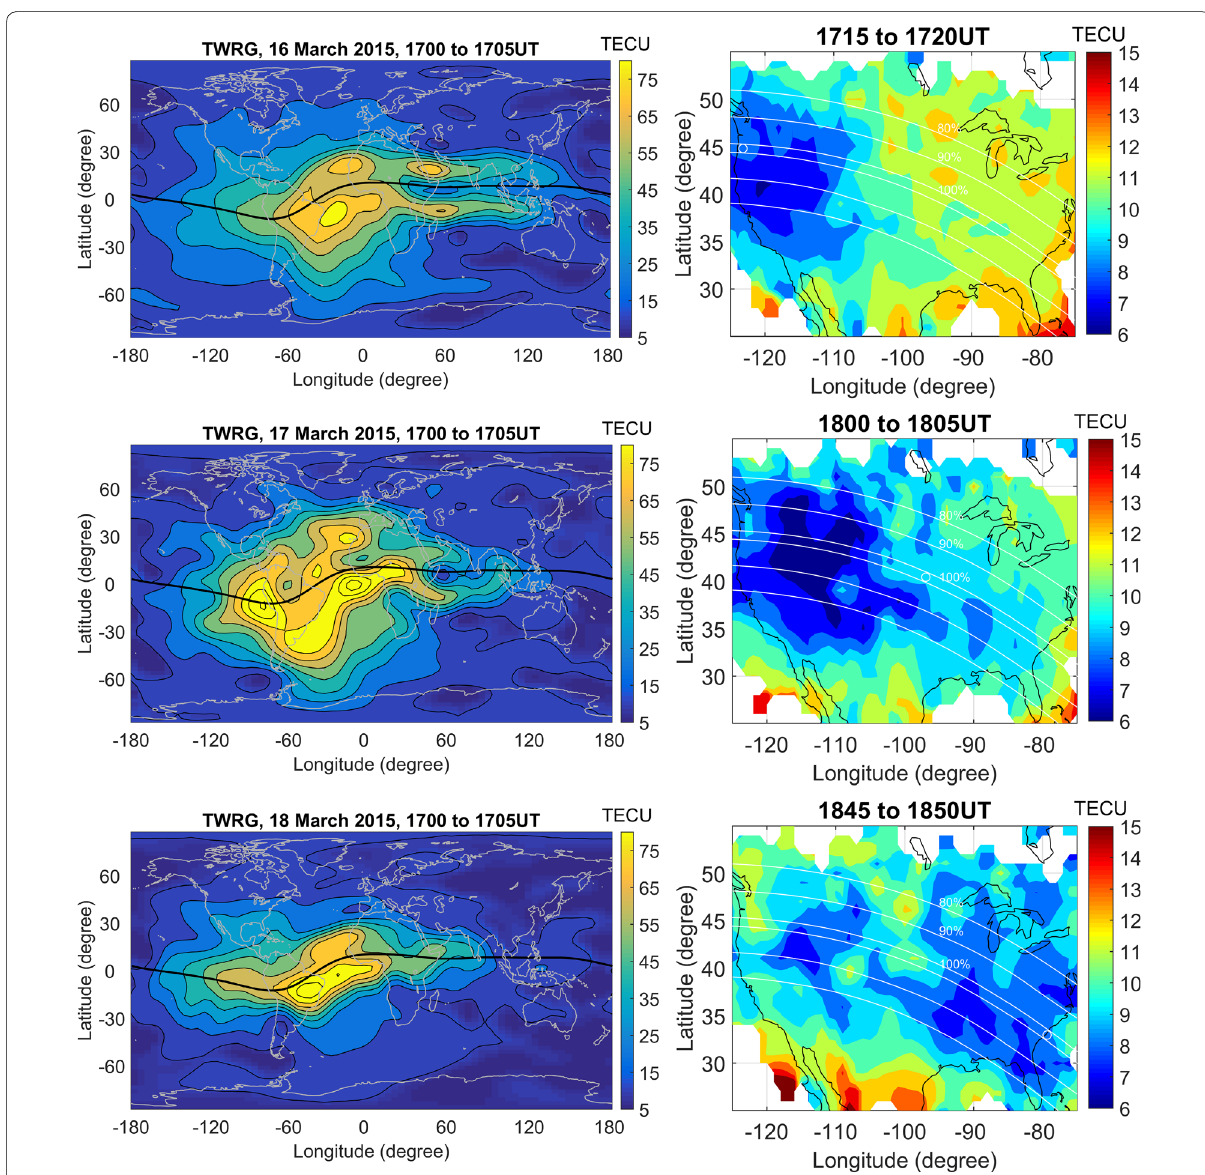
Fig. 1 Changes of total electron content (TEC) during the ionospheric weather events of (Left) the magnetic storm on 16–18 March 2015 and (Right) the moon shadow of the total solar eclipse over Northern America on 21 August 2017. The dark curve in the left panels denotes the magnetic equator. The white open circle in the right panels indicates